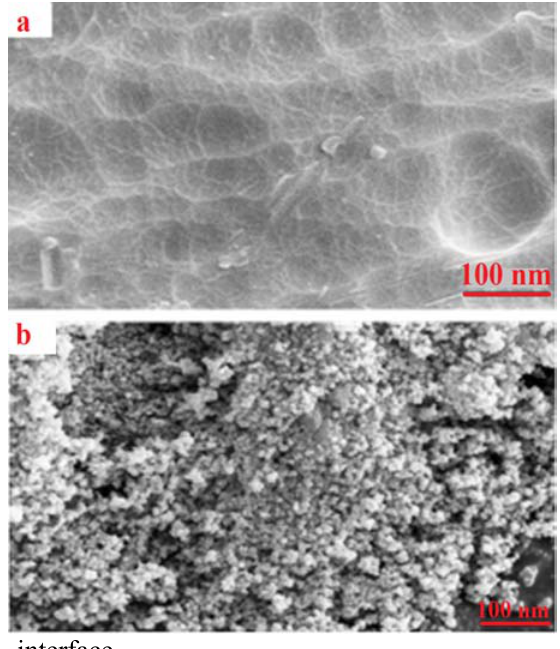
Fig 5. SEM images of the (a) abraded AA3004 and (b) electrosynthesized polyaniline-TiO nanocomposite coated AA3004 for 15 mAcm -2